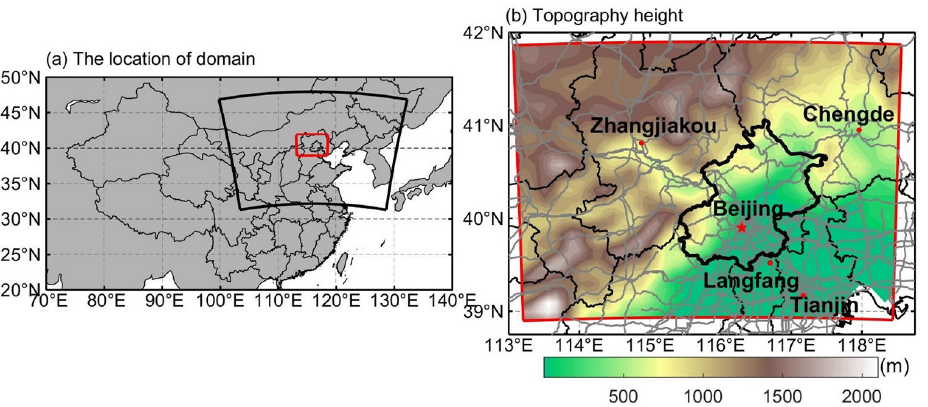
Figure 1. (a) Map of East Asia with Chinese provincial boundaries marked in black. The 10km WRF domain (red box) is nested inside the 30km resolution domain (large black sector), which is centred on 116 ◦ E, 40 ◦ N on a Lambert projection. (b) The topography and primary roads (grey curves) of the 10km resolution domain from panel (a) . The provincial boundaries are marked in black with the heavier line demarking the Beijing region. The major metropolitan centres of Beijing, Tianjin, Chengde and Langfang are marked in red. Table 1. The simulations in our study. Periods Scenarios Goal of the simulation Historical Compare ISIMIP statistical downscaling and bias correction with WRF Assess the performance of ISIMIP and WRF with bias correction